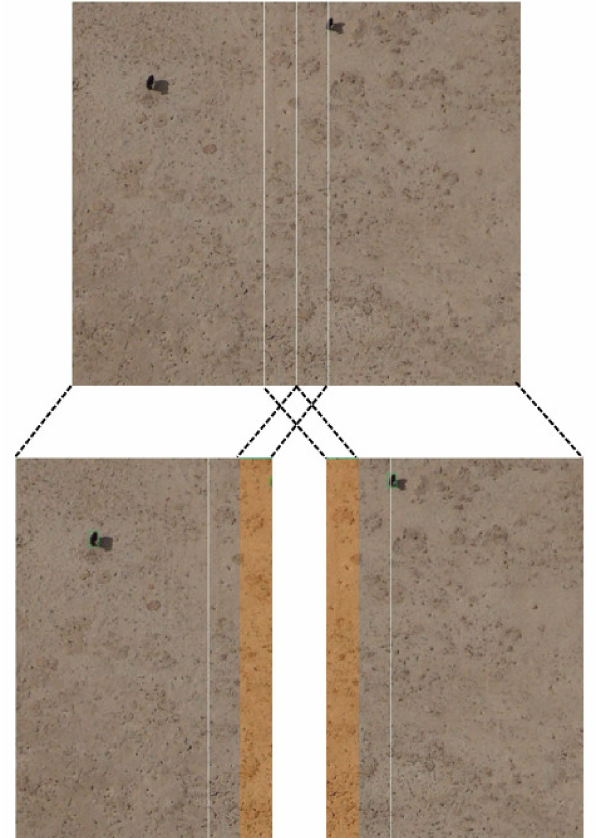
Figure 11. Overlapping segmentation method proposed in this paper (the green boxes in the figure are the detection result boxes of the original Faster-RCNN model using the original overlapping segmentation